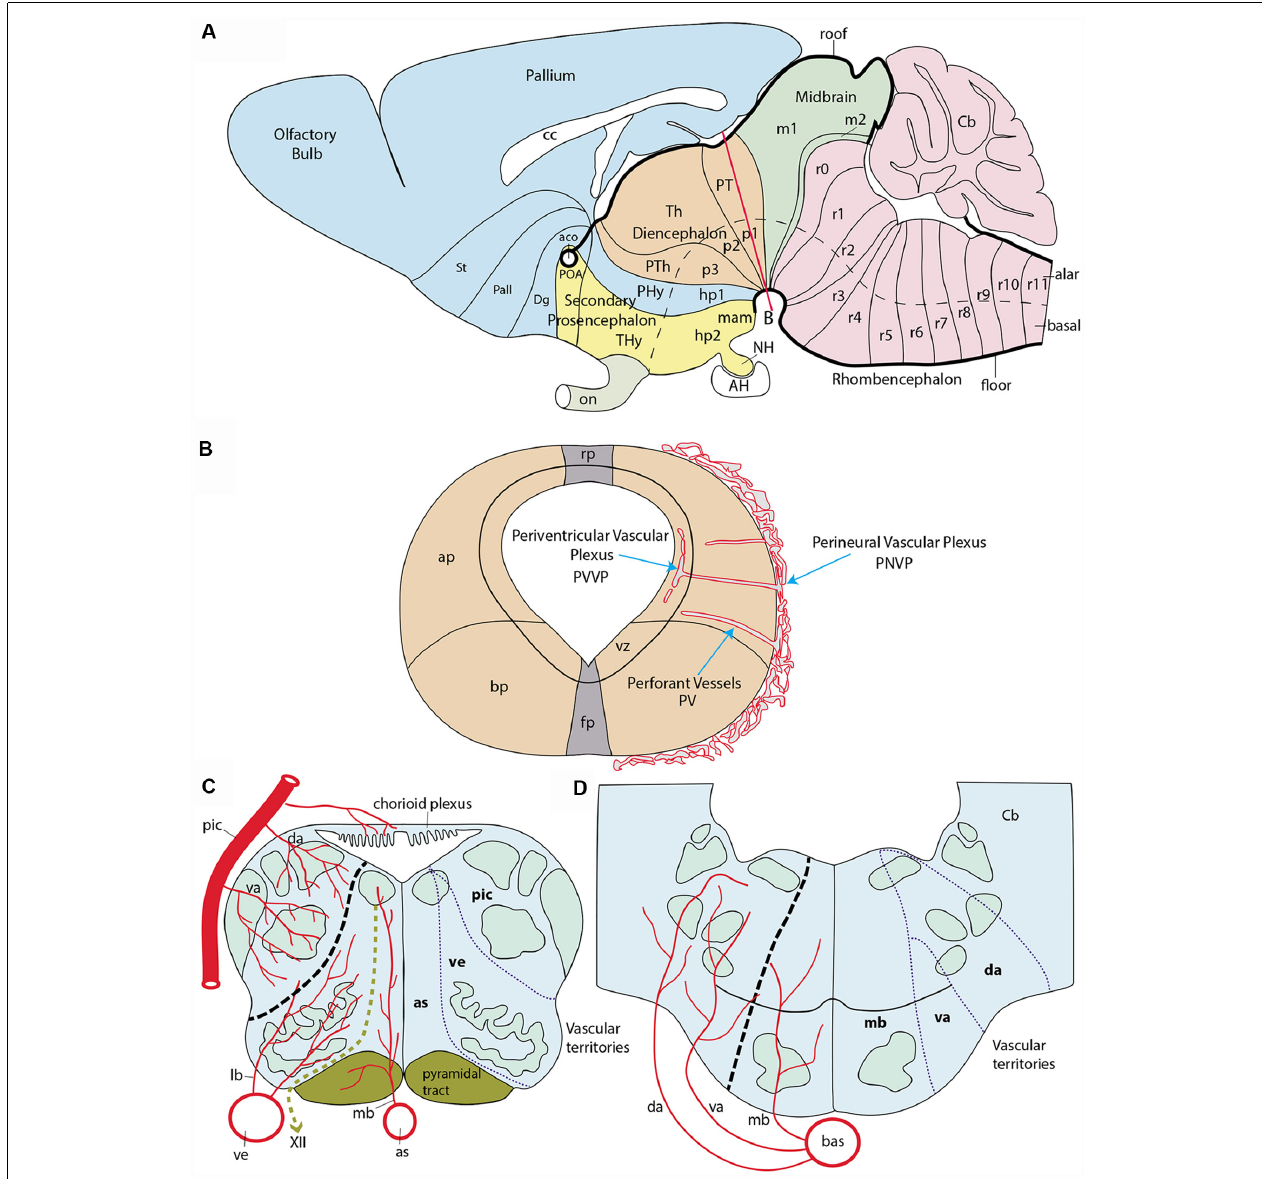
FIGURE 1 | Schematic introduction to topologic mapping of brain arteries, based on the rodent brain. (A) Lateral view of updated prosomeric model showing color-coded forebrain and hindbrain regions, subdivided into neuromeric units (pink = hindbrain, r0-r11; green = midbrain, m1, m2; cream = diencephalon, p1-p3; blue = first hypothalamo-telencephalic prosomere, hp1, contains peduncular hypothalamus, PHy, and evaginated telencephalon, with pallium and subpallial subdivisions St, Pall, Dg; yellow = second hypothalamo-telencephalic prosomere, hp2, contains terminal hypothalamus, THy, and unevaginated subpallial preoptic area, POA). The roof and floor plates are marked with thick black lines. Note convergence of transverse interneuromeric boundaries at the cephalic flexure, due to axial bending of the forebrain. The red line finishing near the big letter (B) represents a transversal plane of section through the p1 neuromere. (B) Schematic cross-section at the level marked by red line in (A) . It illustrates the main vascularization steps. The fundamental longitudinal zones, floor, basal, alar and roof plates (fp, bp, ap, rp) are displayed jointly with the alar-basal boundary. Early brain-invading blood vessels form a perineural vascular plexus (PNVP), perforant vessels (PV) and a deep periventricular vascular plexus (PVVP; note the PVVP actually lies within the proliferative ventricular zone, rather than periventricularly). (C) Schema of main basal and alar arterial vessels in the human hindbrain medulla. The black dash line at left marks the alar-basal boundary, while the green dash line identifies the hypoglossal nerve root. Direct penetrating mediobasal and laterobasal branches (mb, lb) originate respectively from the longitudinal anterior spinal (as) or vertebral (ve) arteries, while arteries serving the alar plate, representing so-called short or long circumferential vessels, distinguish ventral and dorsal levels of this domain. We identify them as ventroalar (va) and dorsoalar (da) arteries. At this particular level the va and da branches originate from the postero-inferior cerebellar artery (pic), but otherwise, they each originate directly from the basilar artery. The respective as, ve (basal) and pic (alar) dependent fields are delimited at right. (D) Schema of main basal and alar arterial vessels in the human hindbrain pons. The black dash line at left marks the alar-basal boundary. Mediobasal (mb) as well as ventrolar and dorsoalar (va, da) arteries arise as lateral branches of the basilar artery (bas) and penetrate radially their respective basal and alar terminal fields, delineated at the right